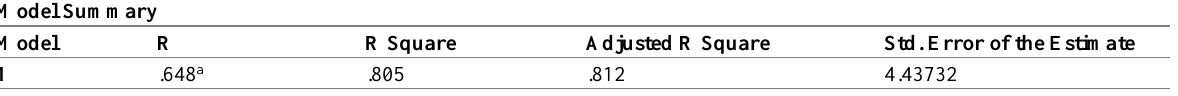
Table 10: Regression Analysis of The Relationship Between Responsiveness and Customer Satisfaction